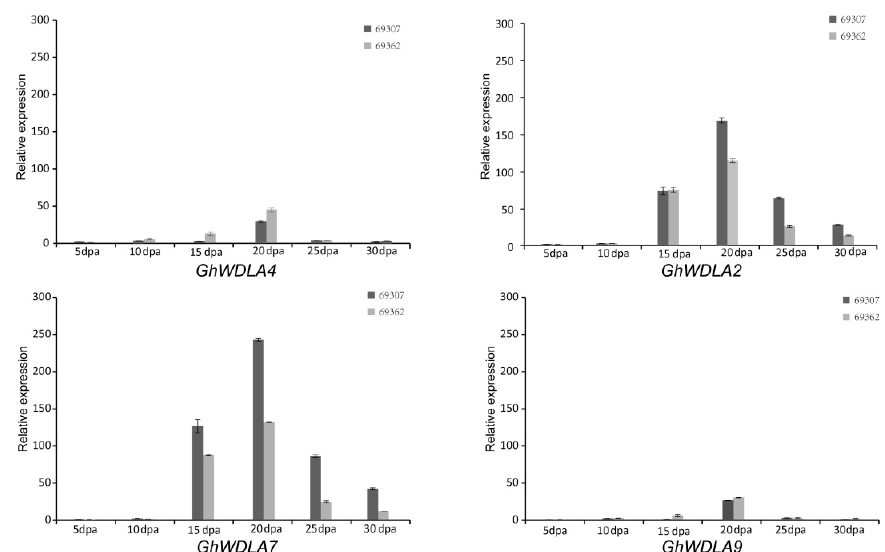
Figure 6. The relative expression levels of selected genes in different fiber developments in 69307 and 69362 determined using qRT-PCR. The relative expression levels were normalized against the reference gene GhHistone3 . The error bars represent the standard deviations of three experiments.